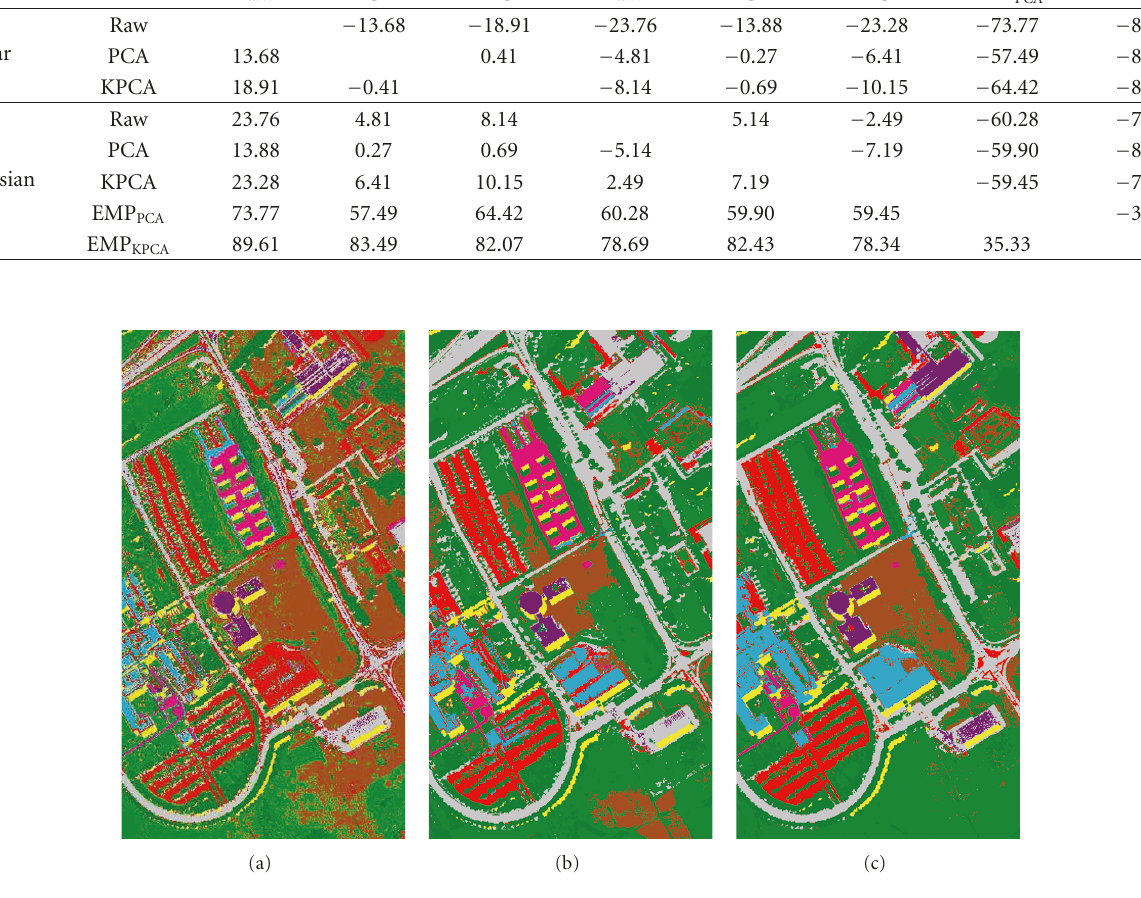
Figure 7: Thematic map obtained with the University Area. (a) Raw data, (b) EMP PCA , (c) EMP KPCA . The classification was done by SVM with a Gaussian kernel. The color-map is as follows: asphalt, meadow, gravel, tree, metal sheet, bare soil, bitumen, brick, and